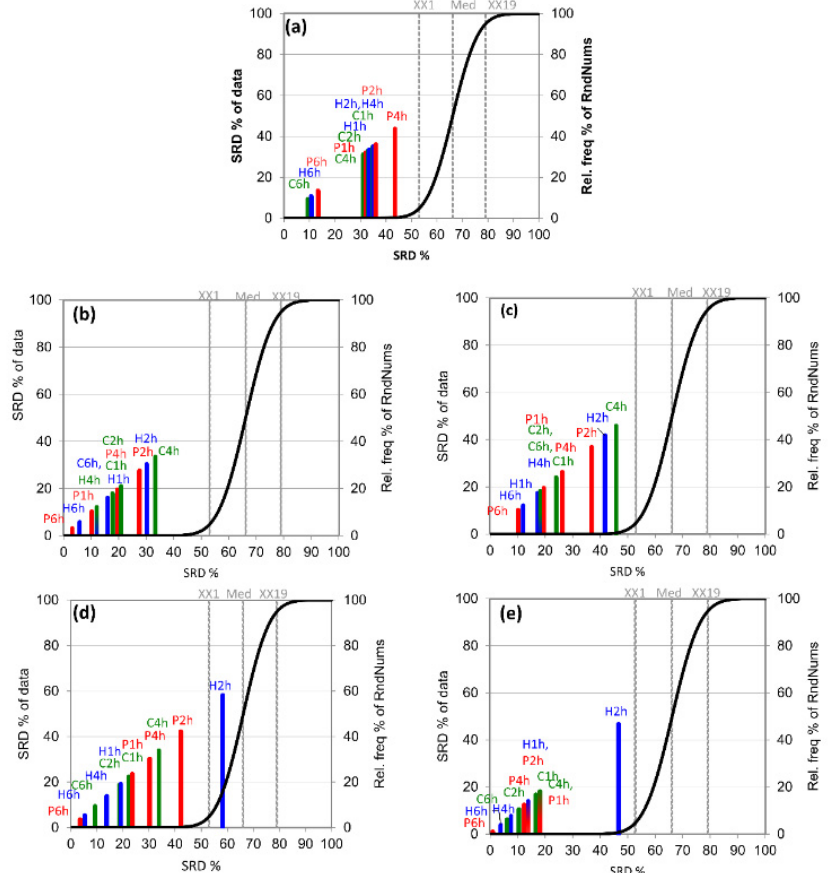
Figure 2. The scaled SRD values of the sampling procedure based on integrated peak area by sum of ranking differences. The maximum values of the compounds (Max) were used as the reference (benchmark) column. Scaled SRD values are plotted on the x-axis and left y-axis; the right y-axis shows the relative frequencies (black curve). Probability levels of 5% (XX1), median (Med), and 95% (XX19) are also given. If a model crosses the cumulative distribution function (XX1), say at p = 0.10, then the method ranks the variable as random with a 10% chance. Diagrams were produced by volatility based on the elution order of total ion chromatogram: ( a ) the first 30 compounds between 0 and 30; compounds between ( b ) 30 and 60, ( c ) 60 and 90, and ( d ) 90 and 120; and ( e ) the last 29 compounds between 120 and 149.